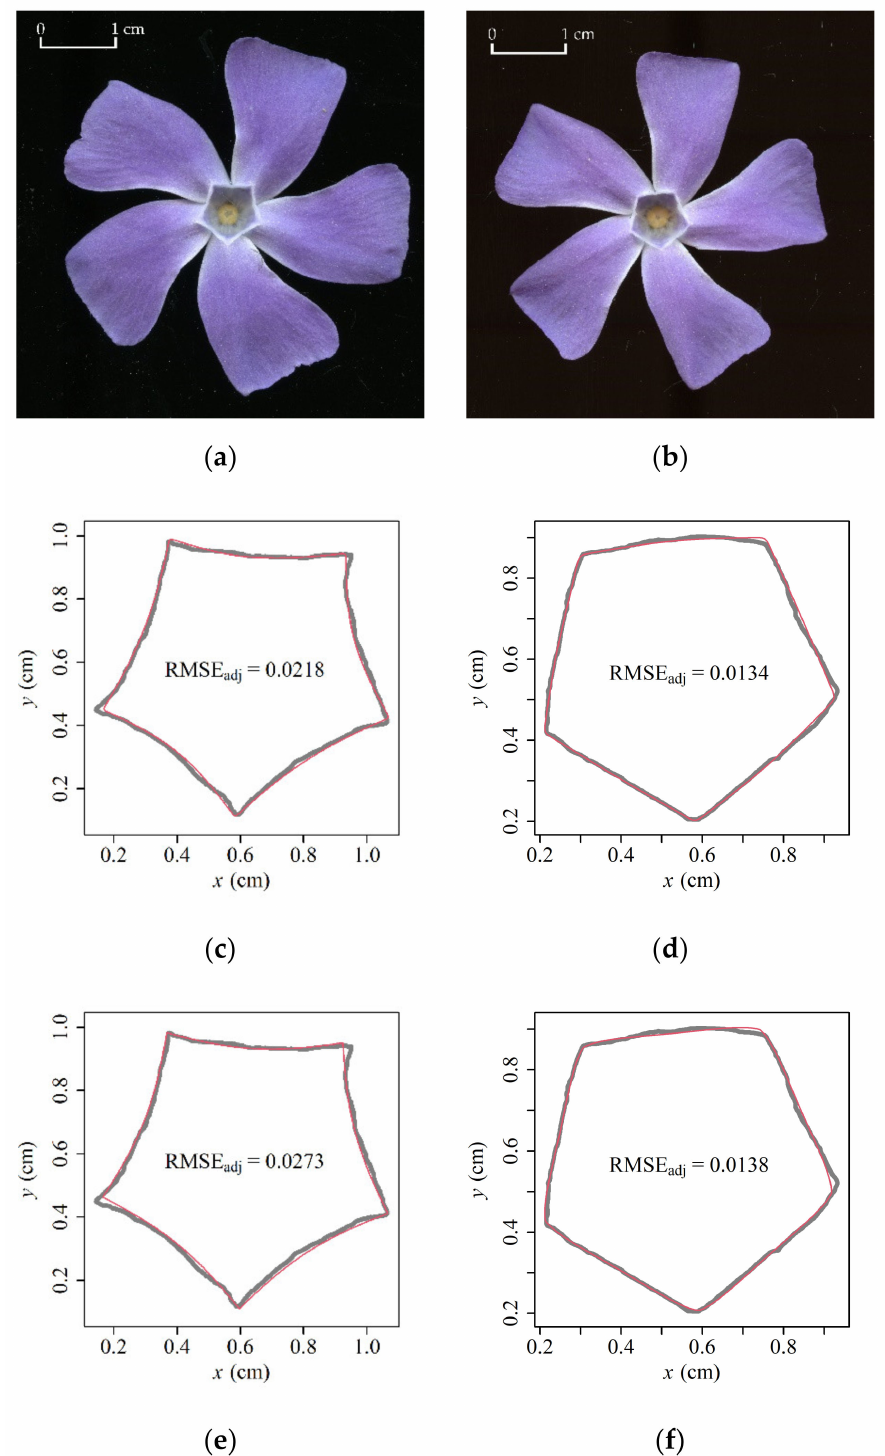
Figure 2. Representative images of V. major flowers with five petals (top view; a , b ), and the measured (gray) and predicted (red) outer rims of corolla tubes (ORCTs) using Model 1 ( c , d ) and Model 2 ( e , f ). The boundary coordinate data of ORCTs were obtained from scanned images, and were fitted by the R package ‘biogeom’. RMSE adj is the adjusted root-mean-square error (Equation